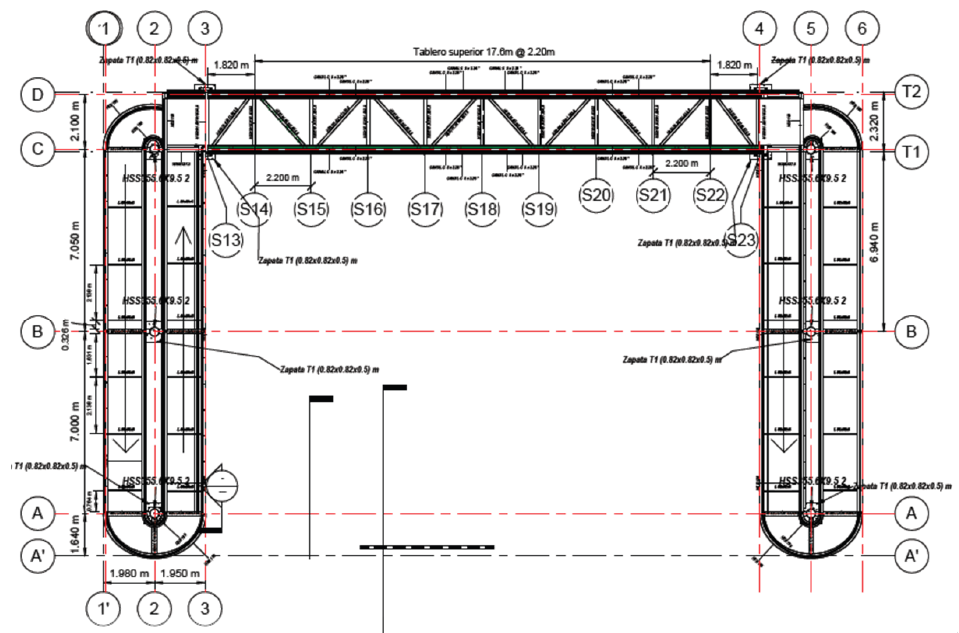
Figure 5. Plan view of the design of the pedestrian bridges under study (schematic view).